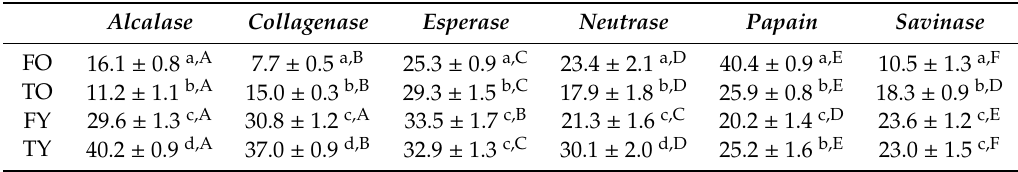
Table 2. FRAP index at 80 °C for each enzyme, expressed as mmol of electrons donated per 100 g of peptides. FO = old femur, 10 years; TO = old tibia, 10 years; FY = young femur, 4.5 years; TY = young tibia, 4.5 years.